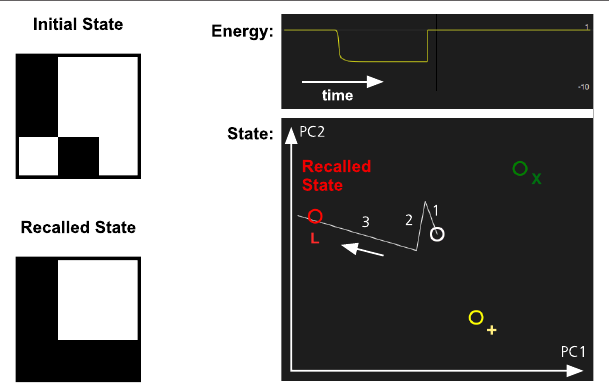
FigUre 3 | Pattern completion in the memory system. The memory has learned three patterns, L (red), X (green), and + (yellow). The partial activation of the L-pattern will make the memory system recall the complete pattern. The graph at the top right shows how the energy of the memory state decreases as the pattern in recalled. The graph below shows the memory state projected on a two-dimensional space defined by the first two principal components (PC1 and PC2) of the stored memory patterns. The graph shows the transition between an initial inactive state (white) and the recalled state (red). The numbers and arrow indicate the sequence of the different transitions.